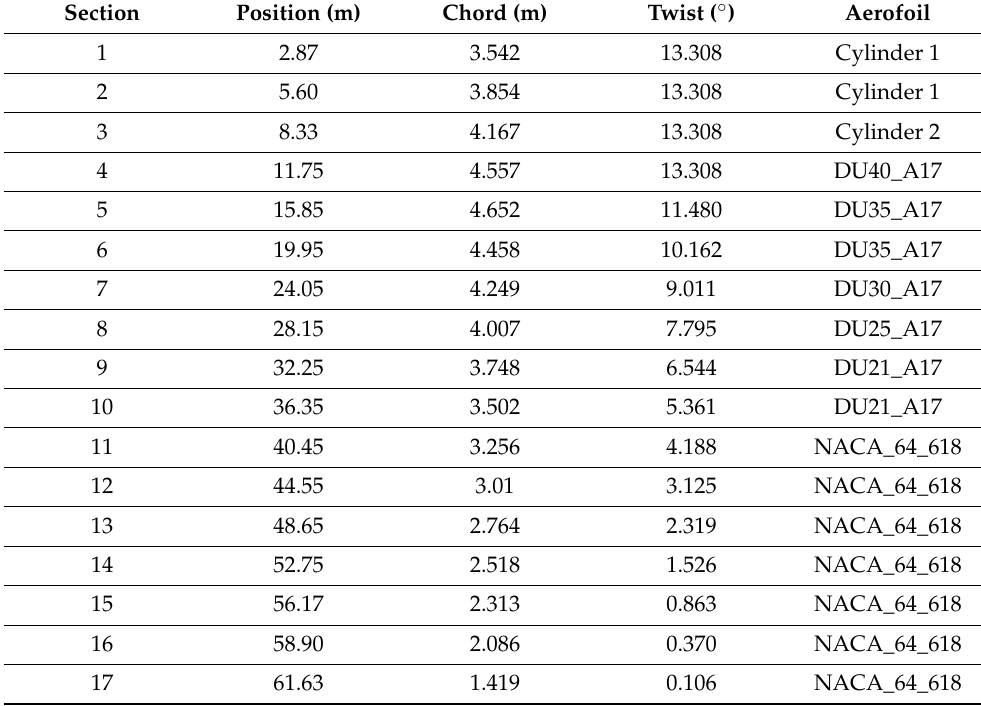
Table 3 [13] for a rated output power of 5 MW, with a rotational speed 12.1 RPM in a wind of speed 11.4 m/s. Table 3. 5 MW NREL wind turbine blade sections and